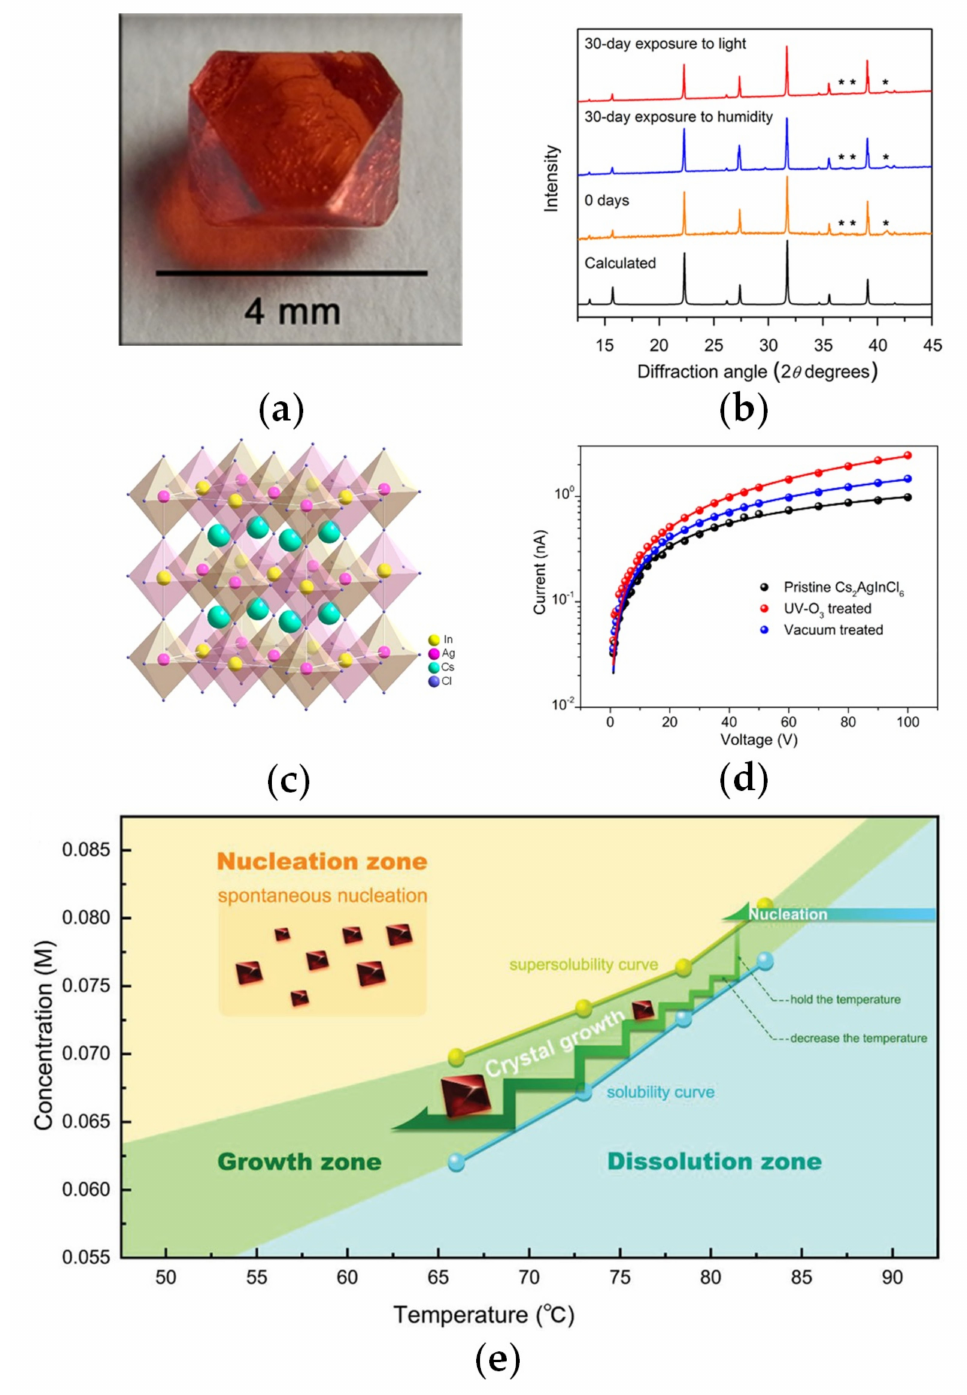
Figure 6. ( a ) The optical image of Cs 2 AgBiBr 6 PSC. Adapted with permission from Ref. [99]. 2016, American Chemical Society; ( b ) XRD patterns of Cs 2 AgBiBr 6 after long-term exposure to environment. Adapted with permission from Ref. [99]. 2016, American Chemical Society; ( c ) structure diagram of Cs 2 InAgCl 6 . Adapted with permission from Ref. [103]. 2018, American Chemical Society; ( d ) pho- toconductivity test of Cs 2 InAgCl 6 PSC under different conditions. Adapted with permission from Ref. [103]. 2018, American Chemical Society; ( e ) solubility and saturation curves of Cs 2 AgBiBr 6 crystal at different temperatures. Adapted with permission from Ref. [101]. 2019, John Wiley and